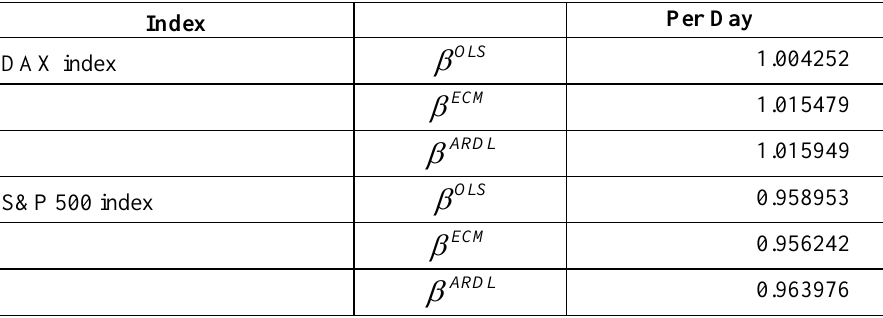
Table 2. Estimated Hedge